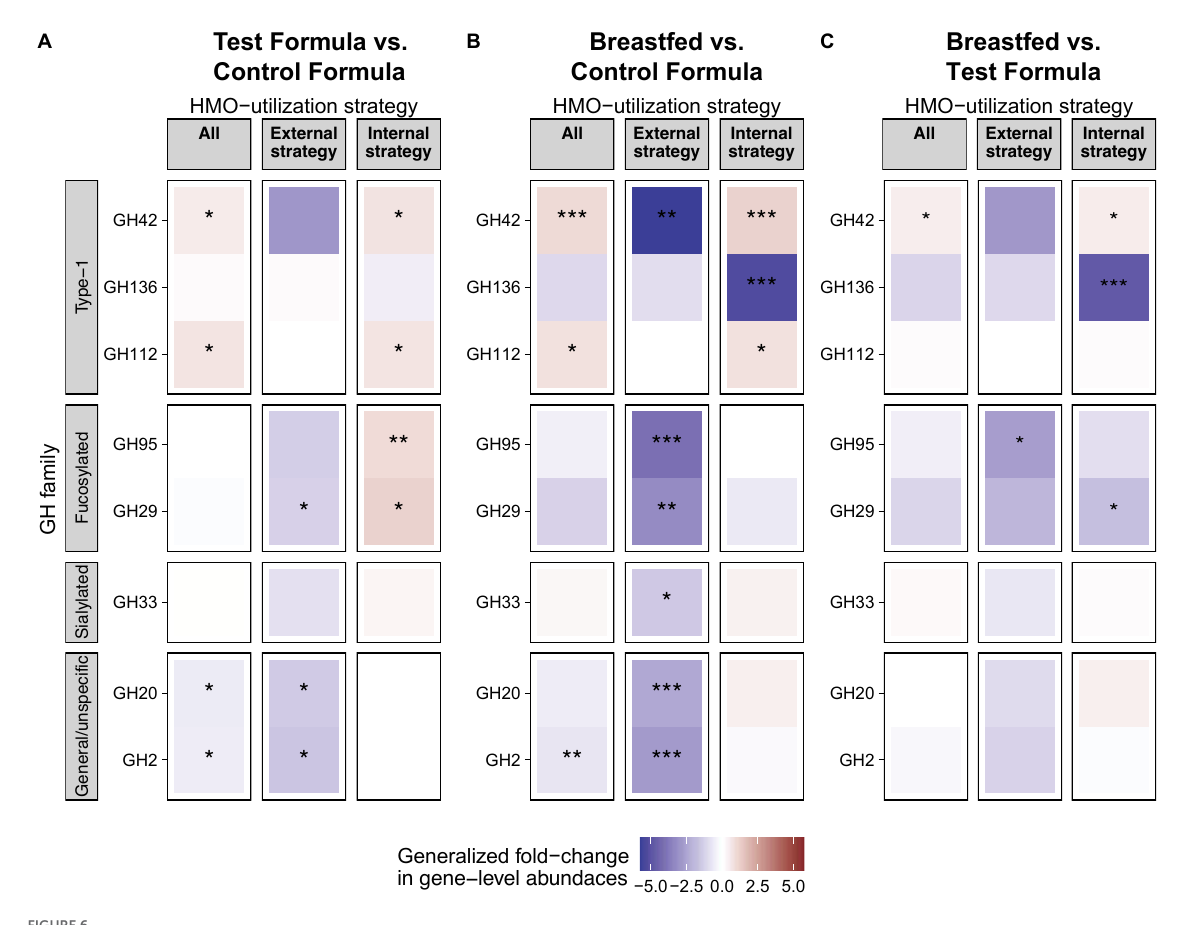
FIGURE6 HMO is associated with differential abundance of HMO utilization genes in the gut. Generalized fold change in gut microbiota gene-level abundances of glucosyl hydrolase (GH) between feeding groups at week 15. Genes were assigned as “external strategy” if they encoded a transmembrane or secretory signal peptide. Genes without a signal peptide were assigned to the group “internal strategy.” “All” includes all genes. GH families were grouped based on their affinity toward specific groups of HMOs. Statistics: Mann–Whitney U -test. P -value cutoffs: * p < 0.05, ** p < 0.01, and *** p <